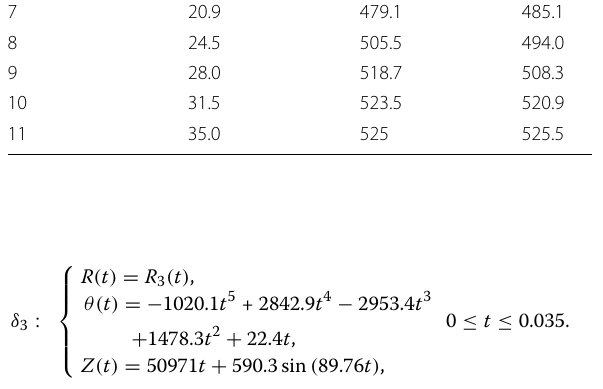
Figure 14 Comparison for three laying pipe curves as function of Eqs. (41), (42) and